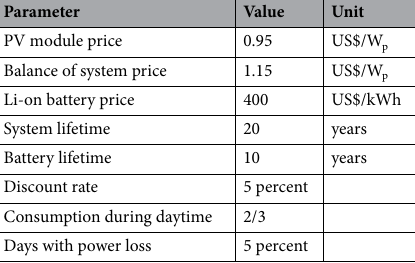
Table 2. Parameters used for the calculation of production costs of PV-based decentralized systems. Sources: Moner-Girona et al. 22 ; Huld et al. 23 .